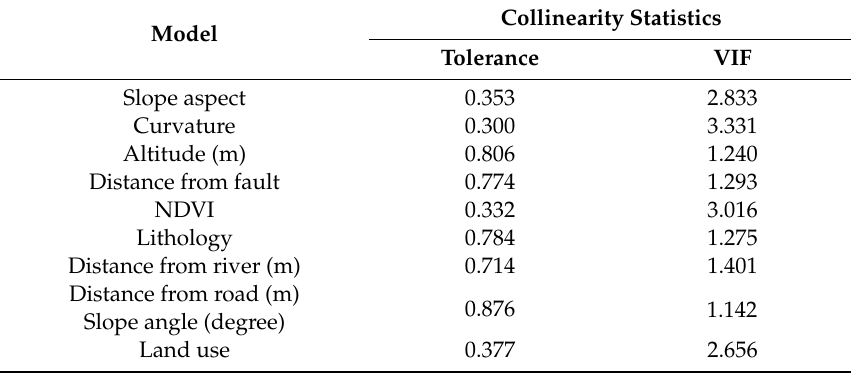
Table 2. Indices of multicollinearity diagnosis for landslide conditioning